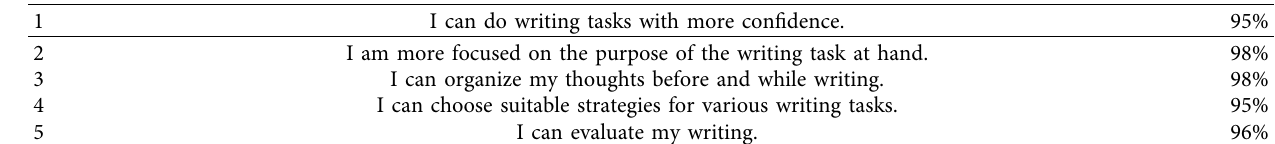
Table 7: Telegram Poll